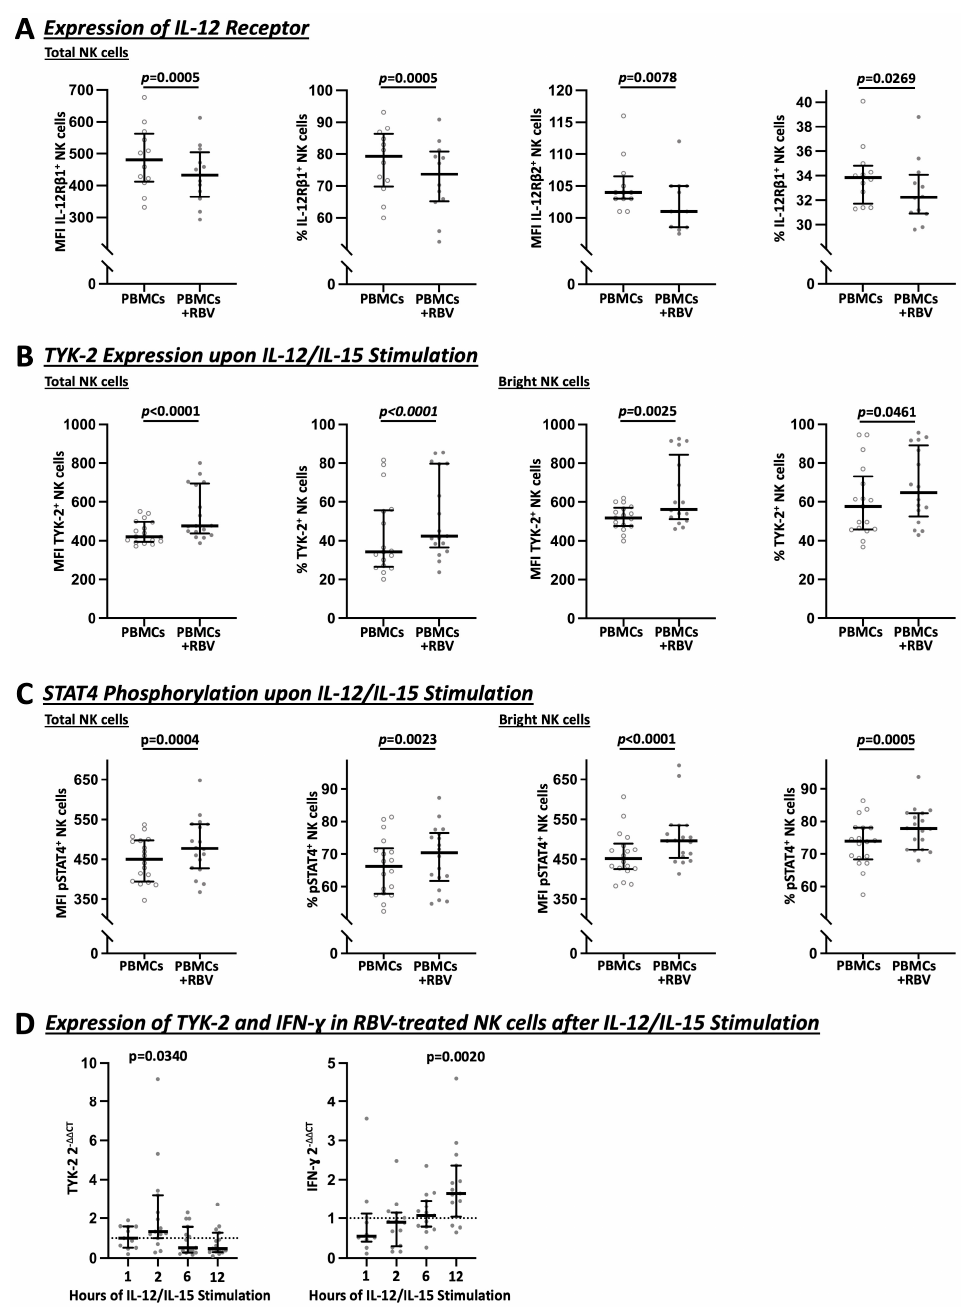
Figure 5. Flow cytometric ( A – C ) and PCR ( D ) analysis of IL-12 signaling in total and bright NK cells under RBV treatment. In ( A – C ), MFI and frequencies compared. ( A ) Expression of IL-12 receptors on NK cells (n = 12). ( B ) Expression of TYK-2 upon IL-12/IL-15 stimulation (n = 17). ( C ) Expression of pSTAT4 upon IL-12/IL-15 stimulation (n = 18). ( D ) Gene expression of TYK-2 and IFN- γ upon IL-12/IL-15 stimulation (n = 10–15 and n = 18). Appearance: median with interquartile range, statistical analysis: Wilcoxon matched-pairs signed-rank test ( A – C ) or one-sample Wilcoxon signed-rank test ( D